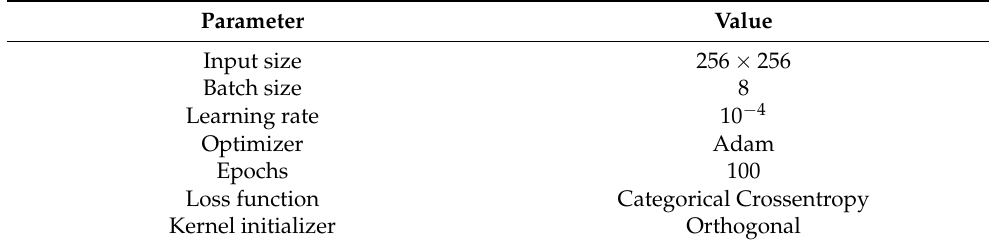
Table 4. Hyperparameters maintained during